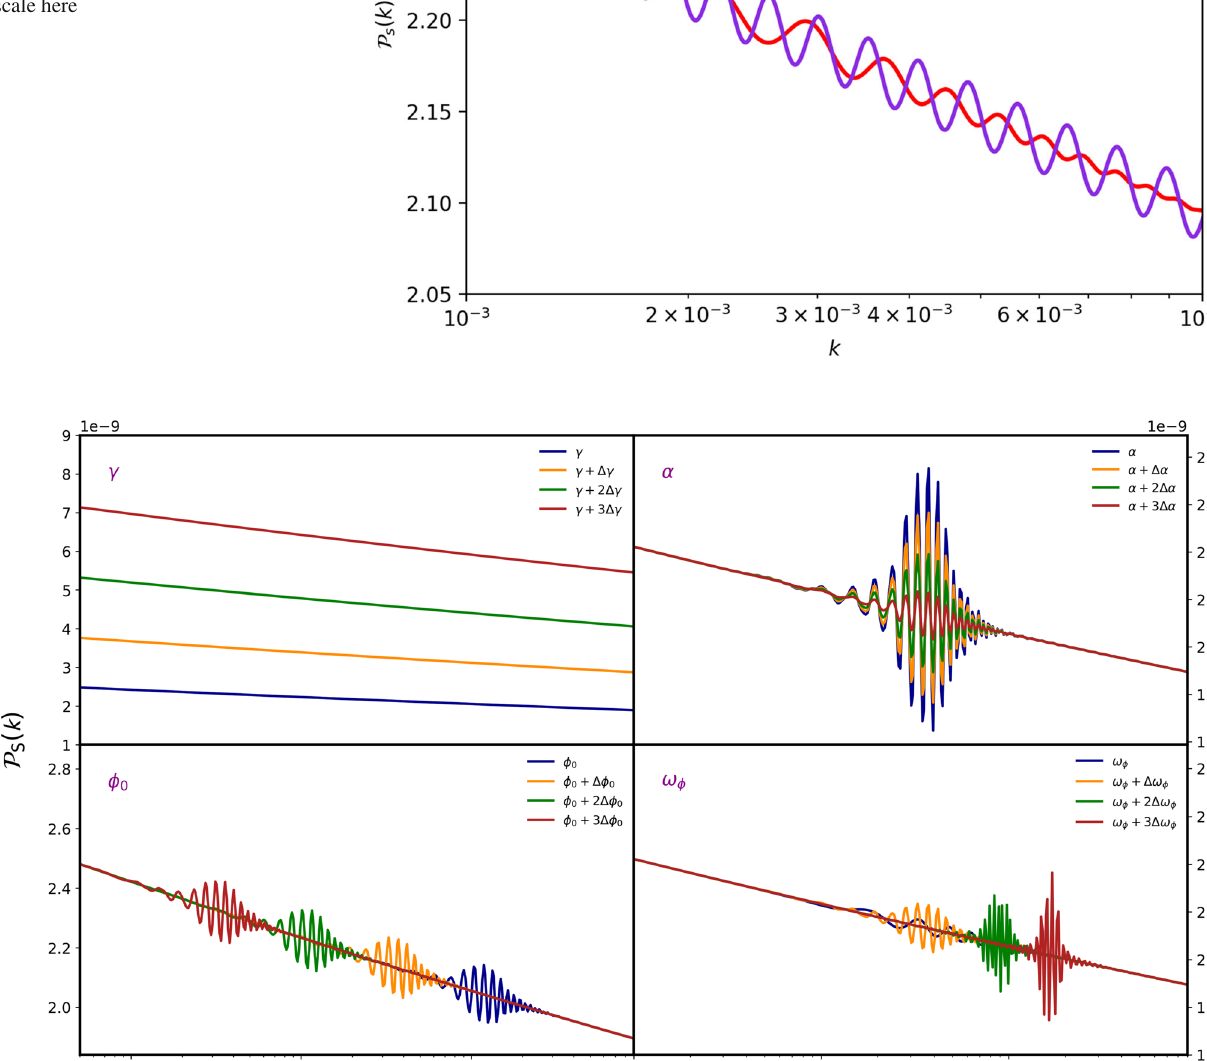
Fig. 2 Variation of the power spectrum in response to changes in potential parameters. Here, we varied one parameter by a specific step size while holding the other three constant. In the upper right corner of each panel, the varying parameter is